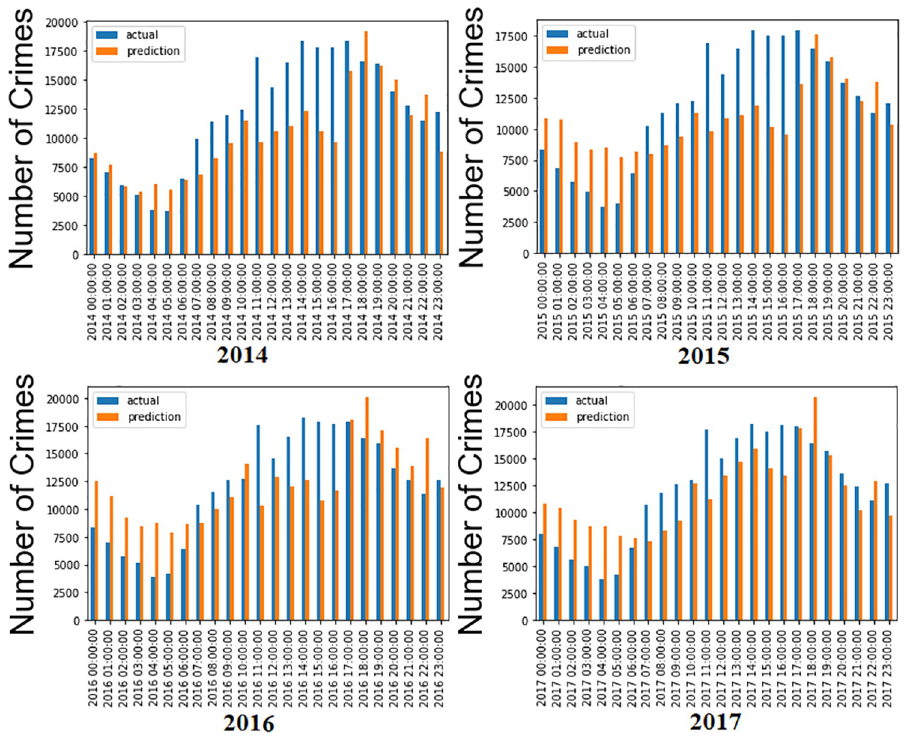
Fig 8. Histogram of seasonal, hourly crime prediction without including crime types. The blue color refers to the actual, while the orange color refers to the forecasting data.